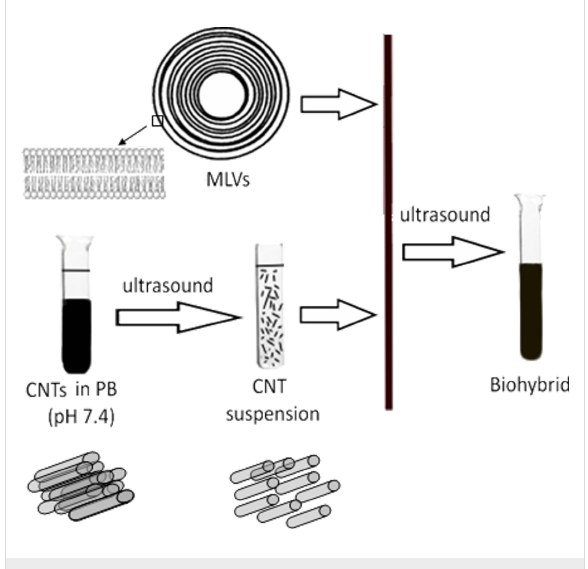
Figure 1: Schematic representation of the biohybrid